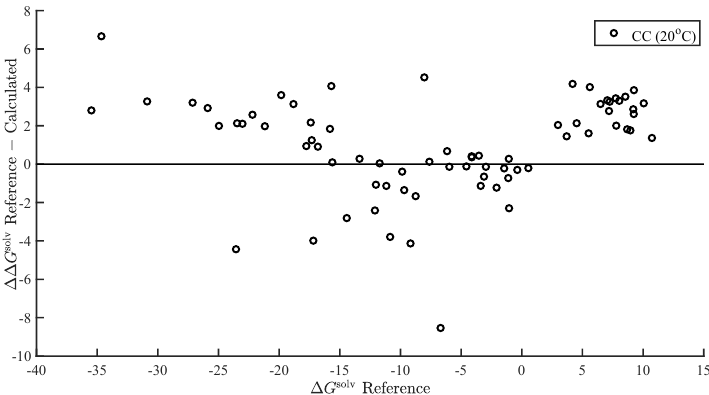
is in units of 2,1